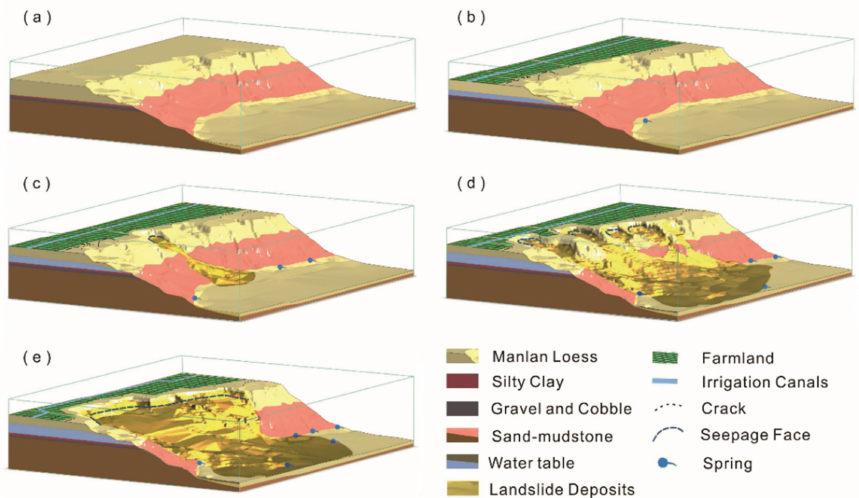
Figure 8. Morphological evolutionary processes of irrigation-induced landslide: ( a ) initial stage; ( b ) irrigation spread and the water table rose sharply; ( c ) the occurrence of landslides; ( d ) retrogression and lateral expansion of landslides; ( e ) landslide clustering and landscape change.